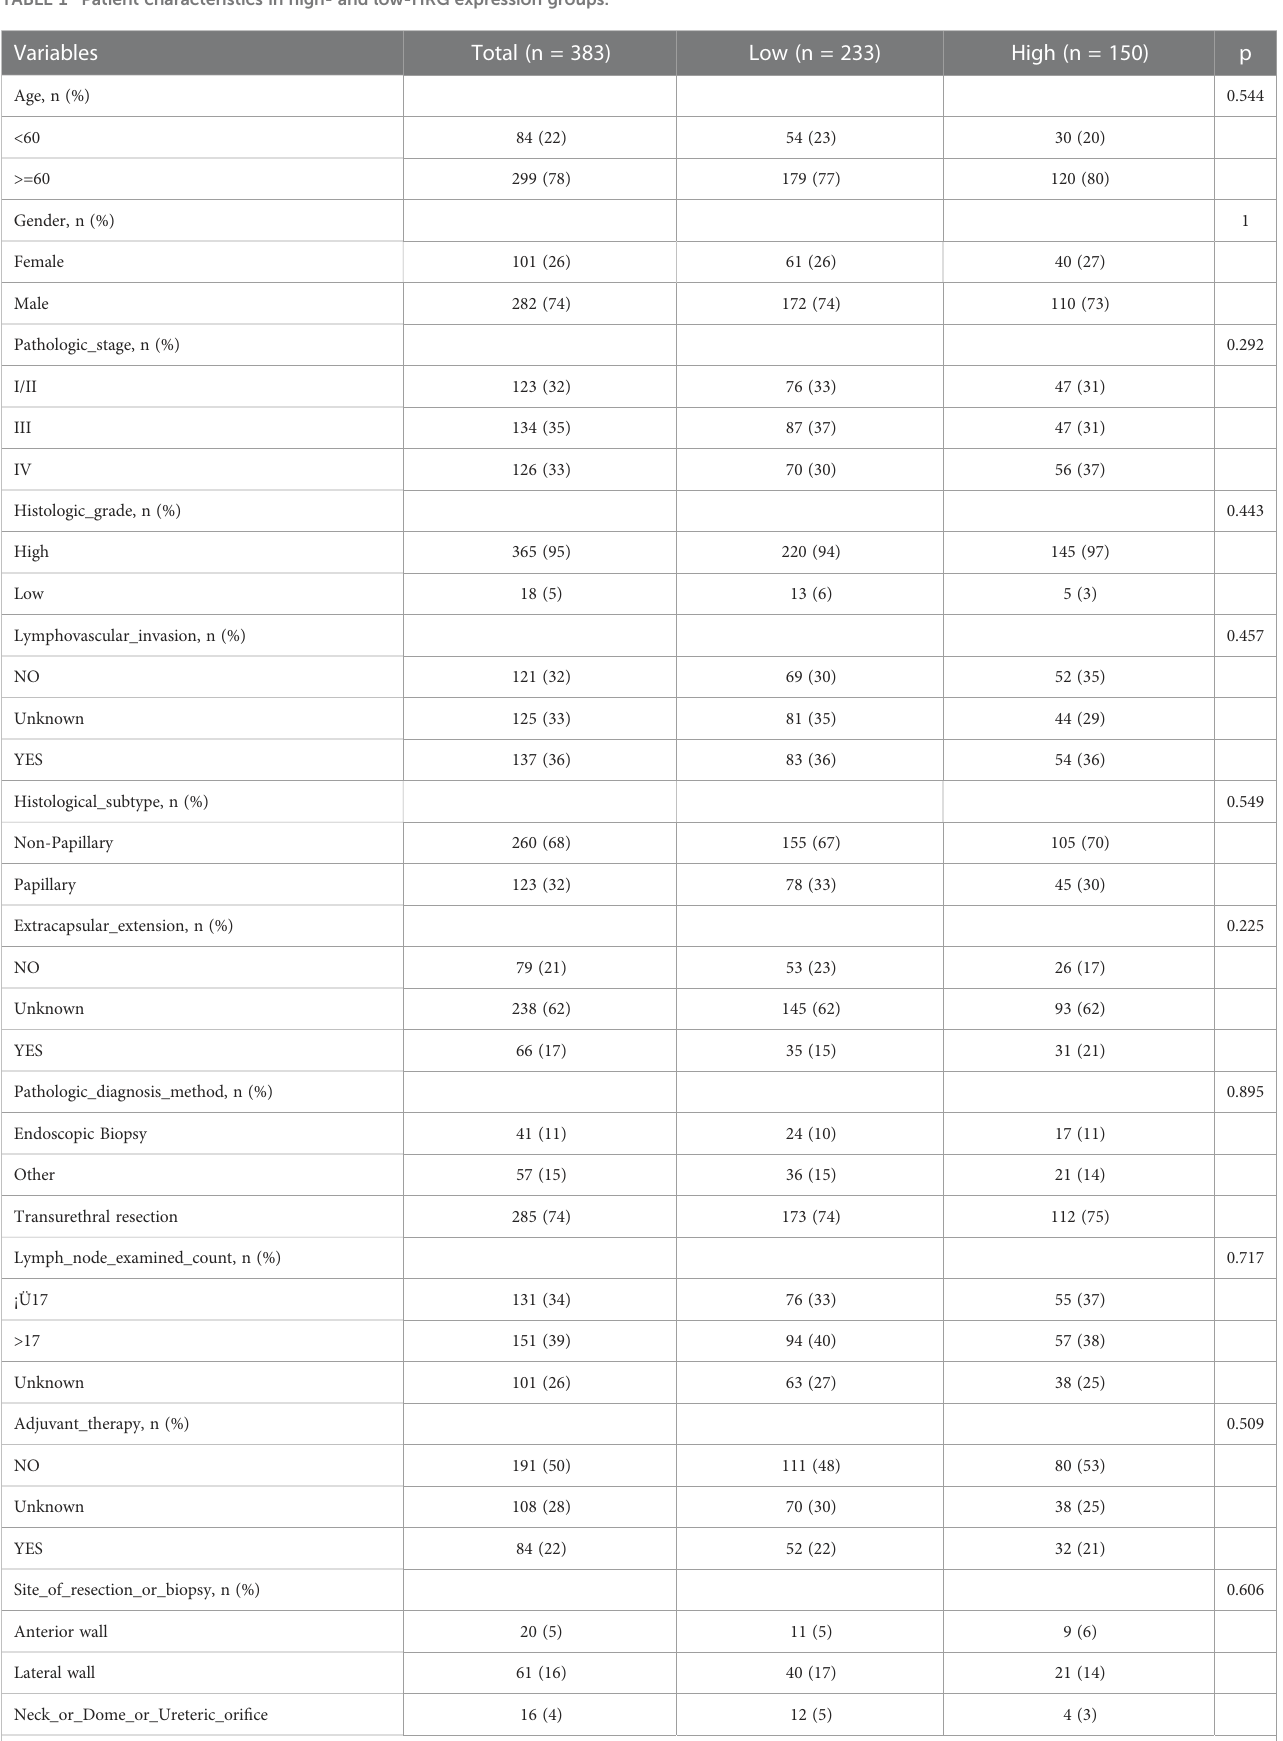
TABLE 1 Patient characteristics in high- and low-HRG expression